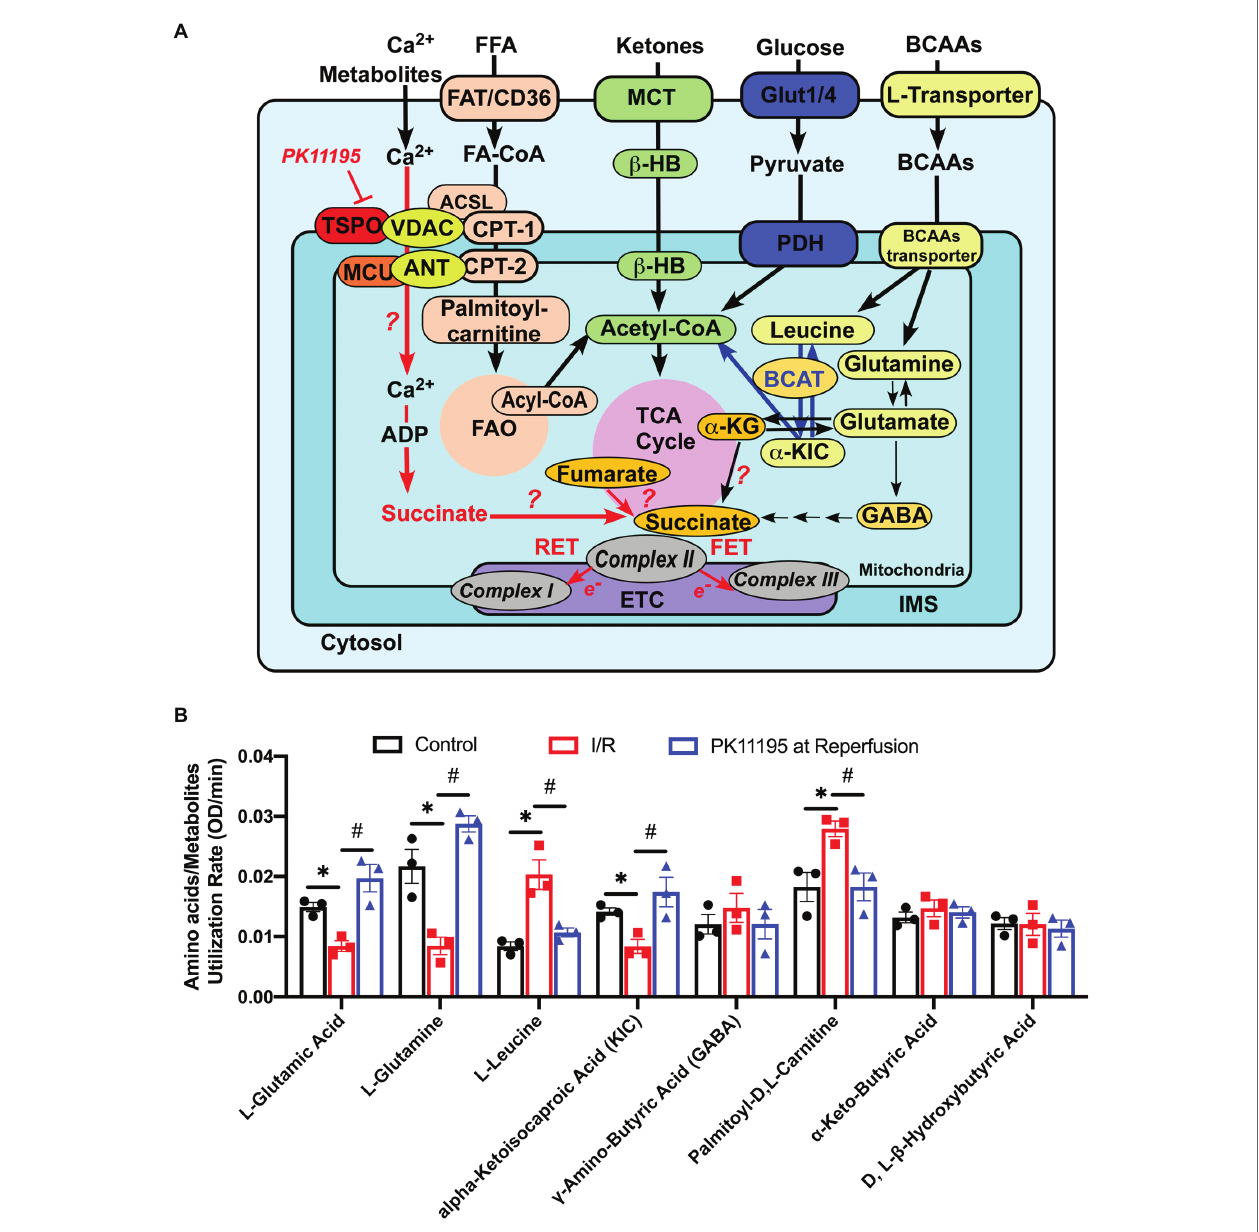
FIGURE 7 | Changes in amino acids, lipid metabolites, and ketone utilization in untreated rabbit cardiac myocytes, and cardiomyocytes exposed to simulated I/R in the absence or presence of 50 μ M PK11195. (A) Schematic representation of amino acids, ketones, glucose, and lipid metabolites utilization in cardiac myocytes. The increase in succinate during I/R could be due to (1) increased supply of glutamate via α -ketoglutarate by transamination, (2) partial reversal of mitochondrial TCA cycle during ischemia and complex II working as fumarate reductase; or (3) potentially by increased delivery of succinate to mitochondria via VDAC. Inhibition of translocator protein of the outer mitochondrial membrane (TSPO) with PK11195 could decrease succinate transport via VDAC and increase mitochondrial Ca 2+ uptake at the same time. For simplicity purpose, mitochondrial complexes IV and V of the electron transport chain (ETC) are not shown. ACSL, long chain acyl-CoA synthetase; BCAT, branched-chain aminotransferase enzyme; β -HB, D, L, β -Hydroxybutyric acid; CPT-1, mitochondrial carnitine palmitoyltransferase 1; CPT-2, mitochondrial carnitine palmitoyltransferase 2; FAO, fatty acid oxidation; FAT/CD36, fatty acid transporters; Glut1/4, glucose transporter; α -KG, α -ketoglutarate; α -KIC, α -ketoisocaproic acid; MCT, monocarboxylate transporter; MCU, mitochondrial Ca 2+ uniporter, VDAC, voltage-dependent anion channel. (B) Summary bars reflected changes in amino acids and metabolites utilization rates in control rabbit cardiomyocytes and cardiomyocytes exposed to 20 min of simulated ischemia and then exposed to simulated reperfusion in the absence or presence of 50 μ M PK11195. Data presented as mean ± SEM obtained from three different animals per each group. * p < 0.05 reflects a significant difference between control cardiomyocytes and cardiomyocytes exposed to simulated I/R; # p < 0.05 reflects a significance between PK11195 treated cardiomyocytes subjected to simulated I/R vs. cardiomyocytes exposed to I/R in the absence of PK11195. There was no difference between control and PK11195 at reperfusion